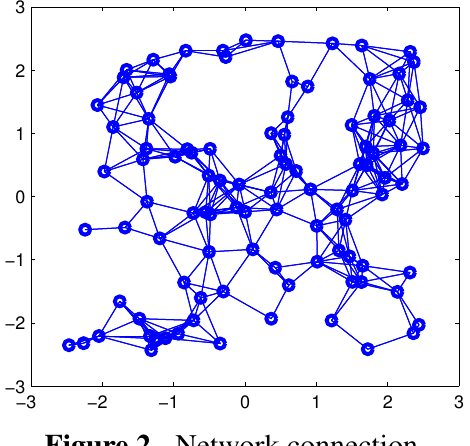
Figure 2. Network